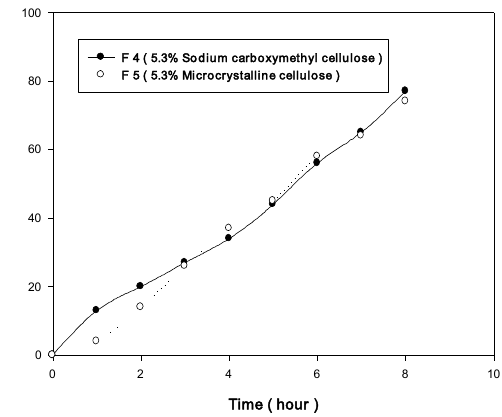
Figure 2: The effect of cellulose derivatives addition on the release of CBZ from ethyl cellulose matrix